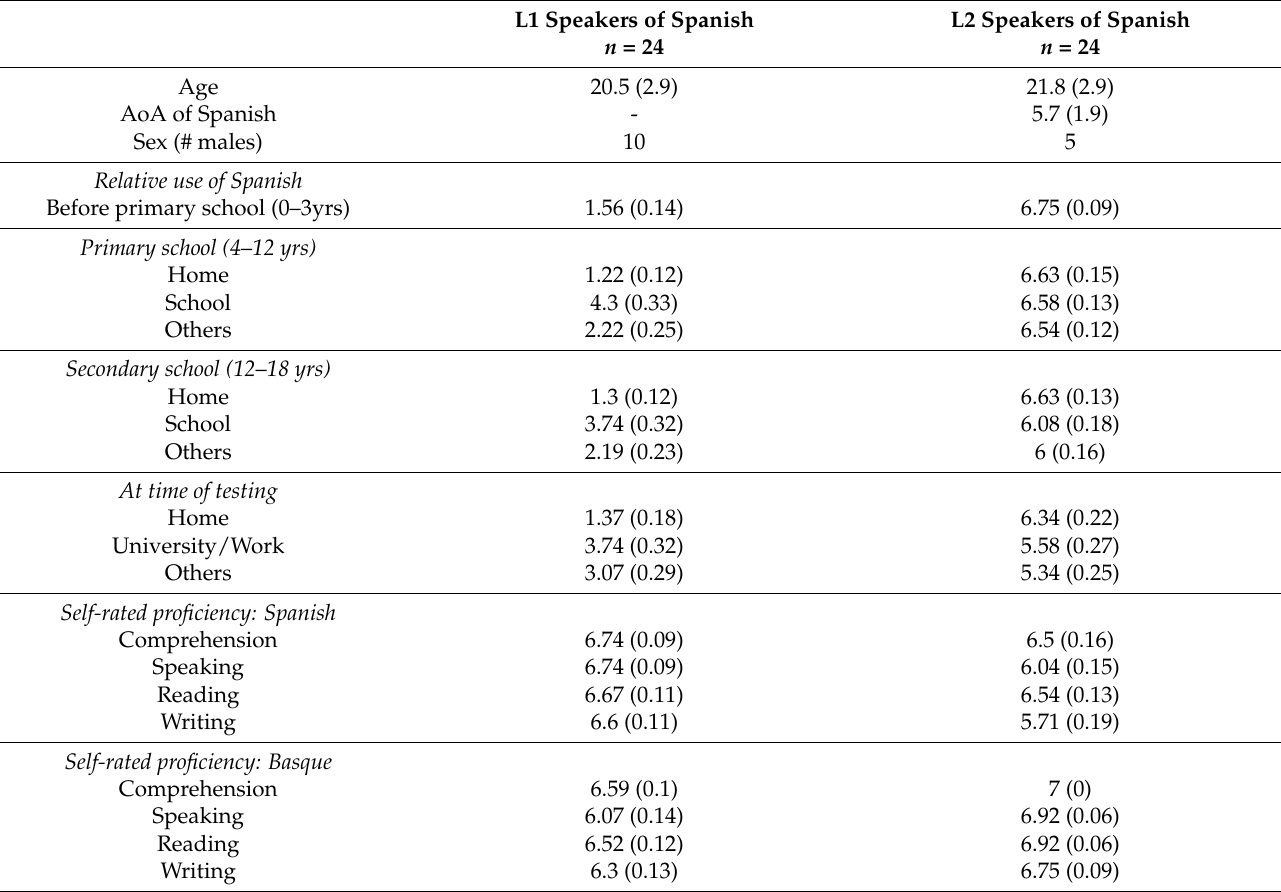
Table 1. The following seven-point scale was applied for measuring the relative use of language: 1 = I speak only Spanish, 2 = I speak mostly Spanish, 3 = I speak Spanish 75% of the time, 4 = I speak Basque and Spanish with similar frequency, 5 = I speak Basque 75% of the time, 6 = I speak mostly Basque, 7 = only Basque. Proficiency level was determined by using the following seven-point scale: 7 = native-like proficiency, 6 = high proficiency, 5 = full proficiency, 4 = working proficiency, 3 = limited proficiency, 2 = low proficiency, 1 = very low proficiency. SDs values are in